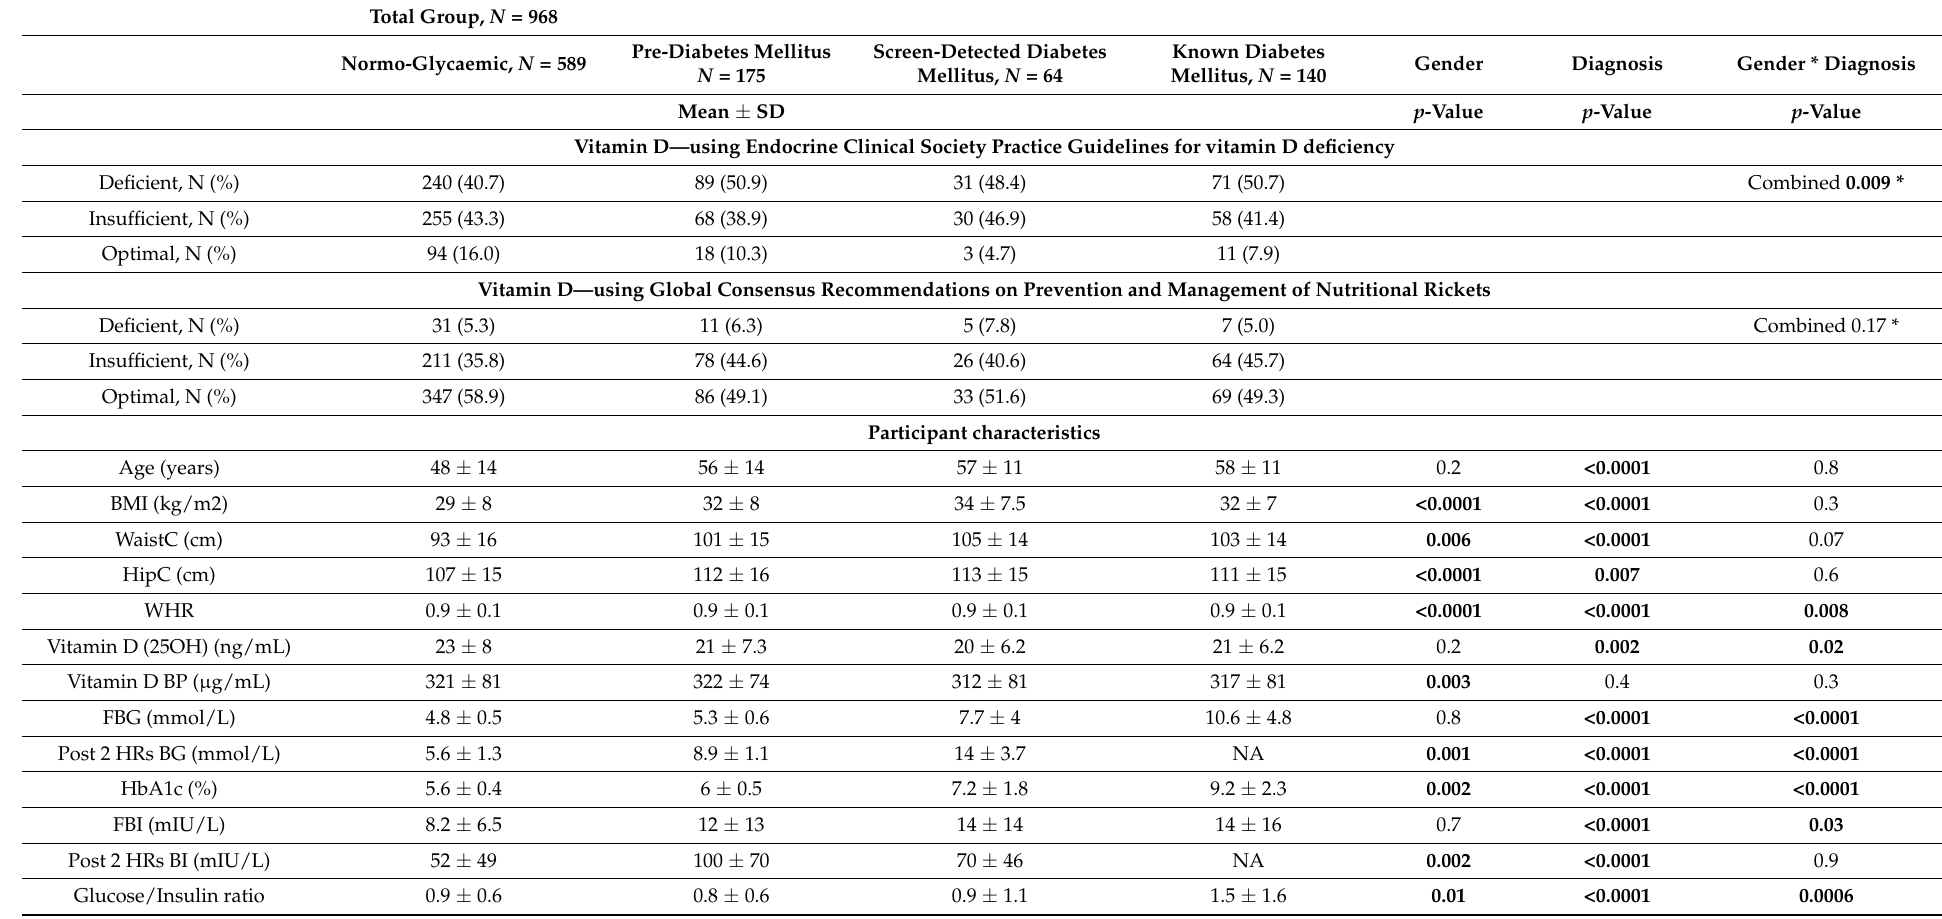
Table 3. Participant characteristics according to glycaemic